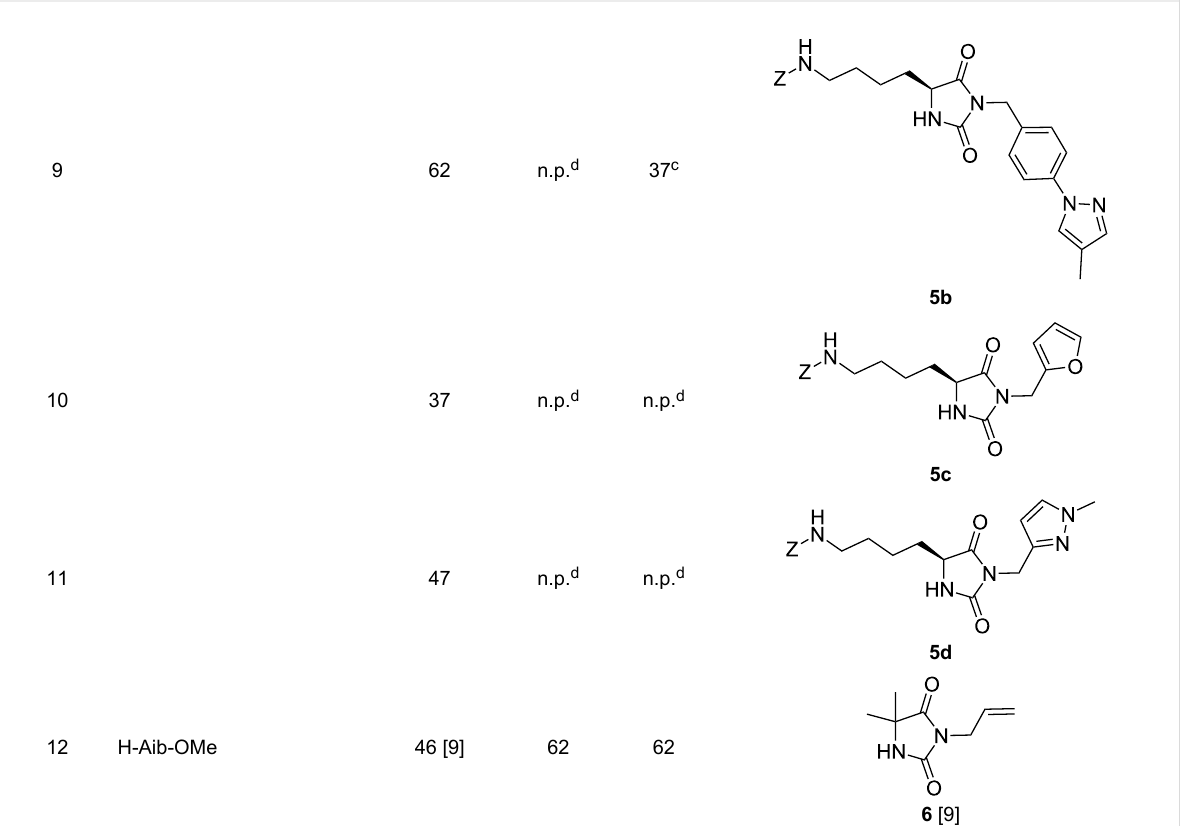
Table 3: Syntheses of 3,5-disubstituted hydantoins under dry-grinding (conditions A) a or PEG-assisted grinding (conditions B and C). b